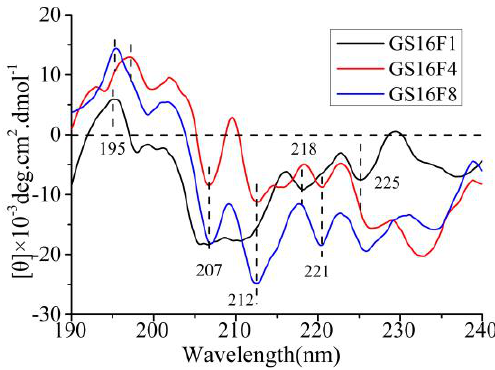
Figure 8. CD spectra of released polypeptides.